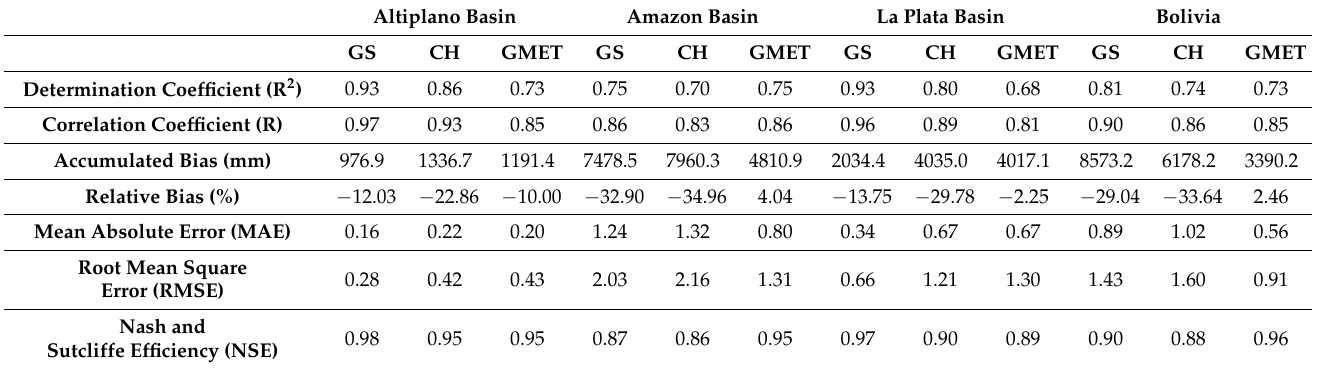
Figure 11. Daily scatter plots of the generated precipitation products for the: ( a ) Altiplano, ( b ) Amazon and ( c ) La Plata basins. Table 2. Statistics indicators for SBP-generated precipitation products in relation to rain